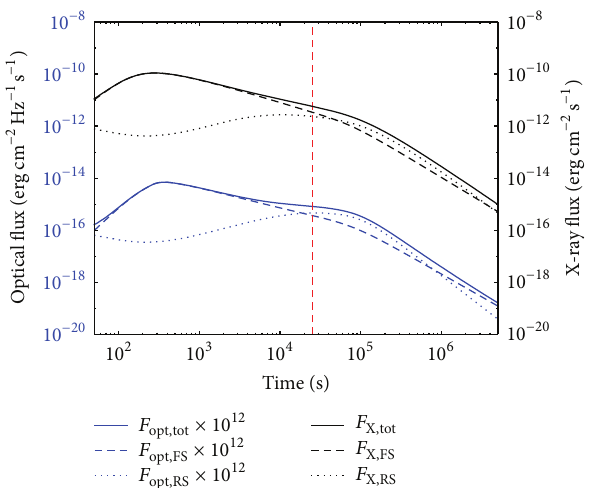
Figure 5: Corresponding afterglow lightcurves of Figure 4. The dashed lines represent the flux from Region 3, while the dotted lines areemissionsfromRegion2.Thetotalfluxisshownasthesolidlines. In the calculations, the optical band is taken as 4.0×10 14 Hz and the X-ray band is taken as 0.3–10 keV. The red dashed vertical line marks the position of 𝑇 sd .